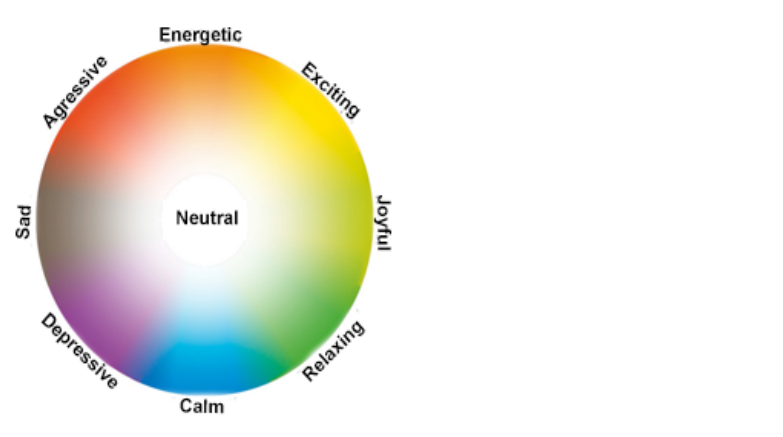
Figure 1. Modified model of mood with fuzzified boundaries of emotions by Plewa and Kostek [25,26].